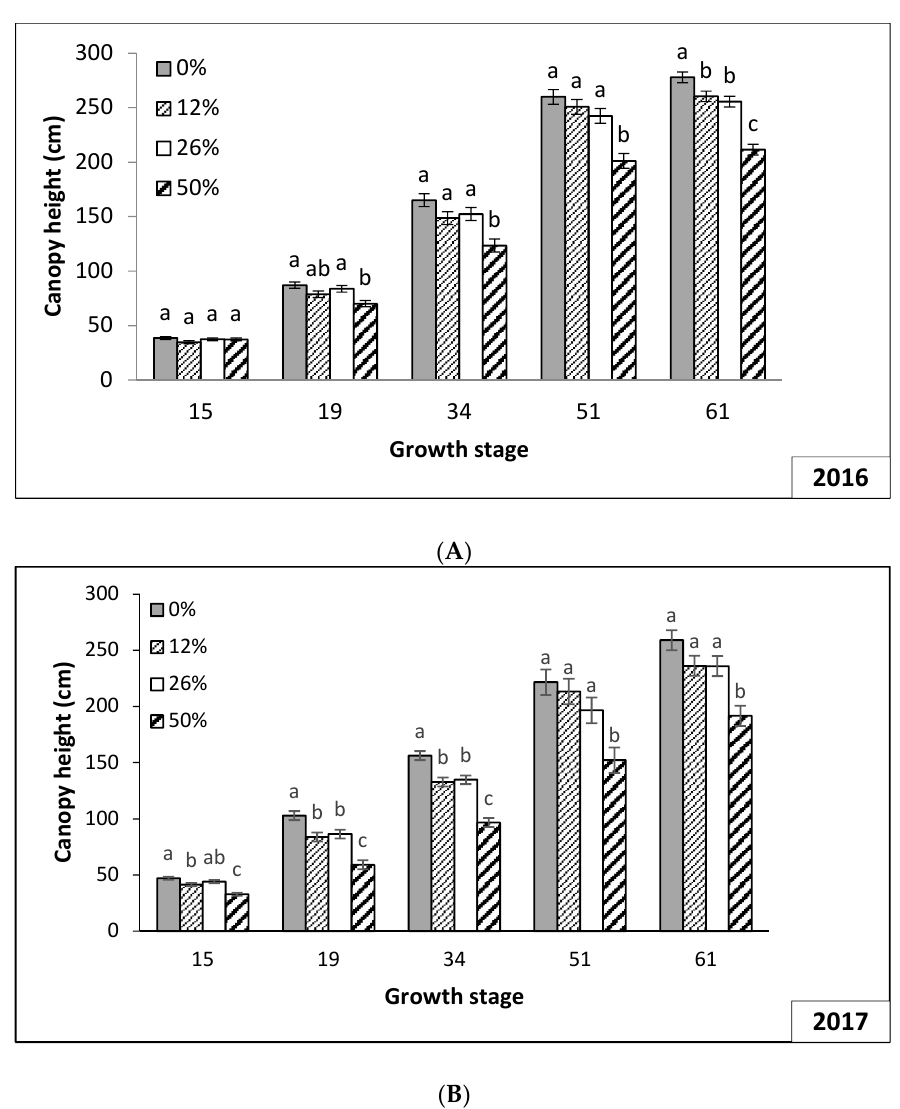
Figure 3. Canopy height (cm) under the different shading levels at the growth stages 15 (5th leaf unfolded), 19 (9th or more leave unfolded), 34 (4 nodes detectable), 51 (tassel initiation), and 61 (silking) of the control in 2016 ( A ) and 2017 ( B ). Black bars represent the standard error of mean. Means with identical letters within a growth stage show non-significant differences between the shade levels (LSD, p < 0.05).